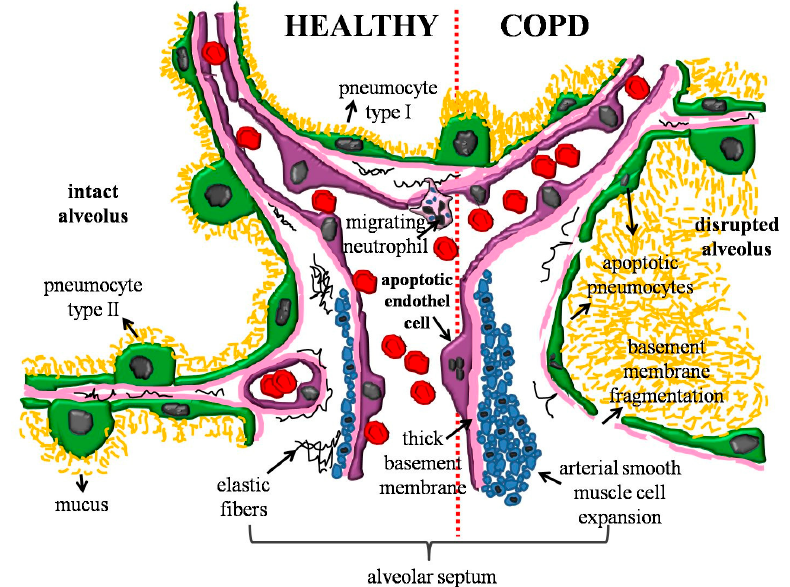
Figure 2. Schematic picture of healthy and COPD alveolar septum. In the COPD pulmonary tissue apoptotic pneumocytes appear in the alveolar wall and the wall becomes disrupted. The basement membrane of the pulmonary epithelium is fragmented. As the result of the enhanced enzyme activity the amount of elastic fibers is decreased. The pulmonary vasculature is thickened with arterial smooth muscle cells.